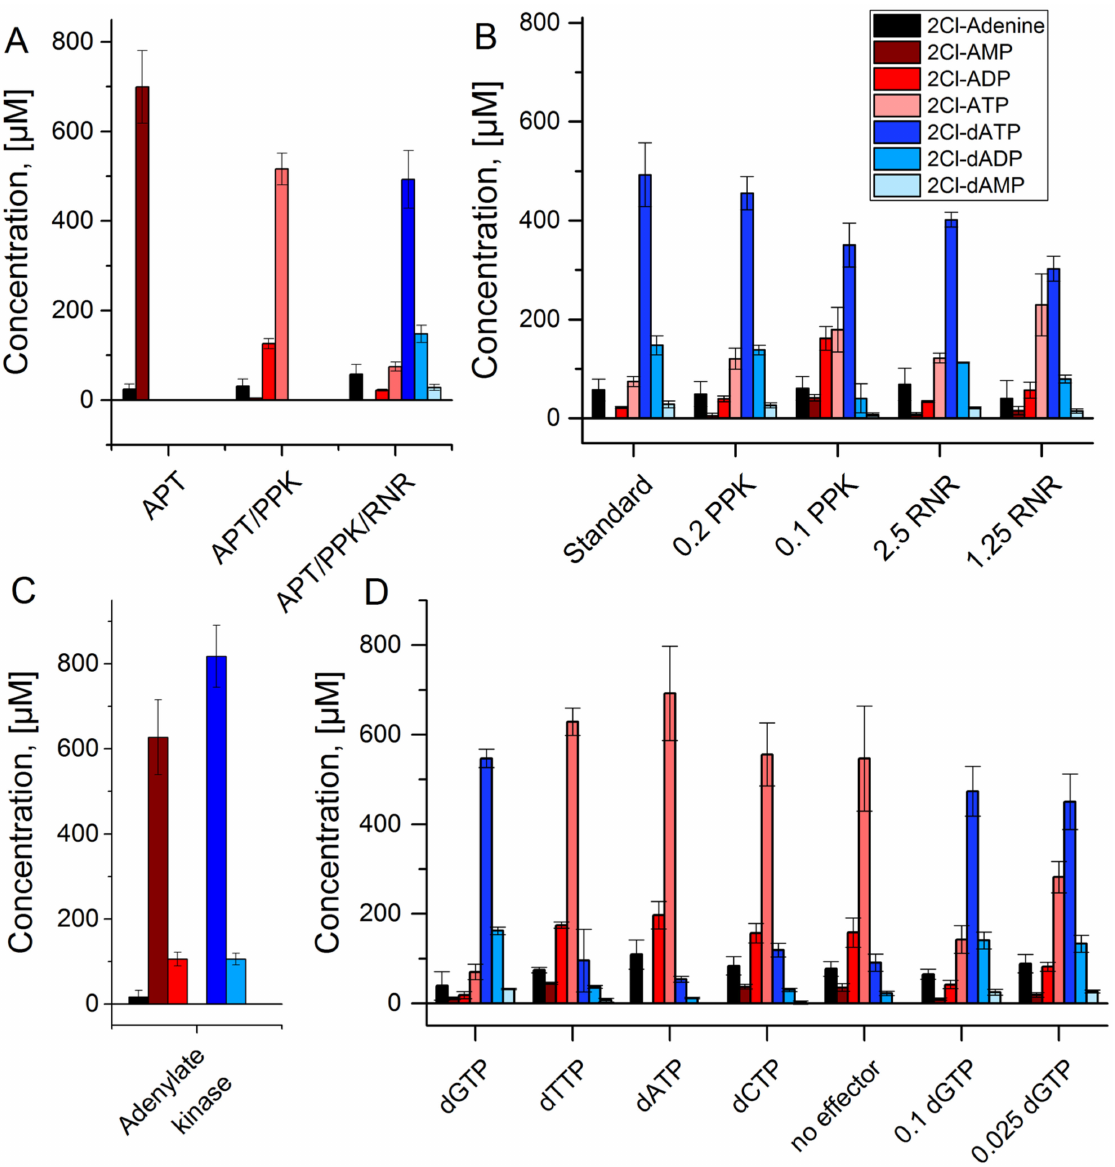
Figure 4. APT-PPK-RNR reaction cascade with 2Cl-adenine as substrate: ( A ) Stepwise assembly of the reaction cascade with APT alone (APT), APT and PPK (APT/PPK), and the full cascade of APT, PPK, and RNR. ( B ) Full reaction cascade with reduced PPK and RNR concentrations in µ mol L − 1 ; standard concentrations are 1 µ mol L − 1 (APT), 0.4 µ mol L − 1 (PPK), and 5 µ mol L − 1 (RNR), respectively. ( C ) Adenylate kinase reaction test with APT (1 µ mol L − 1 ) and PPK (0.4 µ mol L − 1 ) starting with 1 mmol L − 1 2Cl-adenine and 2Cl-deoxyadenosine triphosphate each. ( D ) Full reaction cascade with different effector molecules (0.5 mmol L − 1 ) and different concentrations of the effector dGTP in mmol L − 1